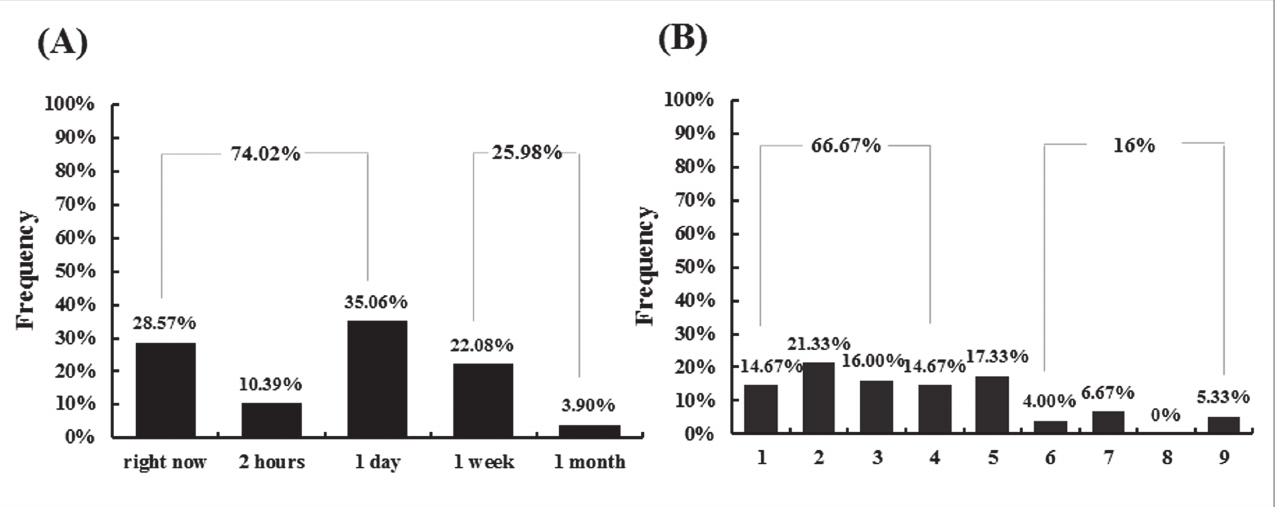
Fig 1. Panel A: The proportion of participants who chose each of the 5 available times at which they wanted to undergo an operation from Study 1a. Panel B: The proportion of participants who chose each of the 9 available rating points to expressed their willingness to delay the exam in Study 1b (1 = not at all willing, 9 = totally willing).